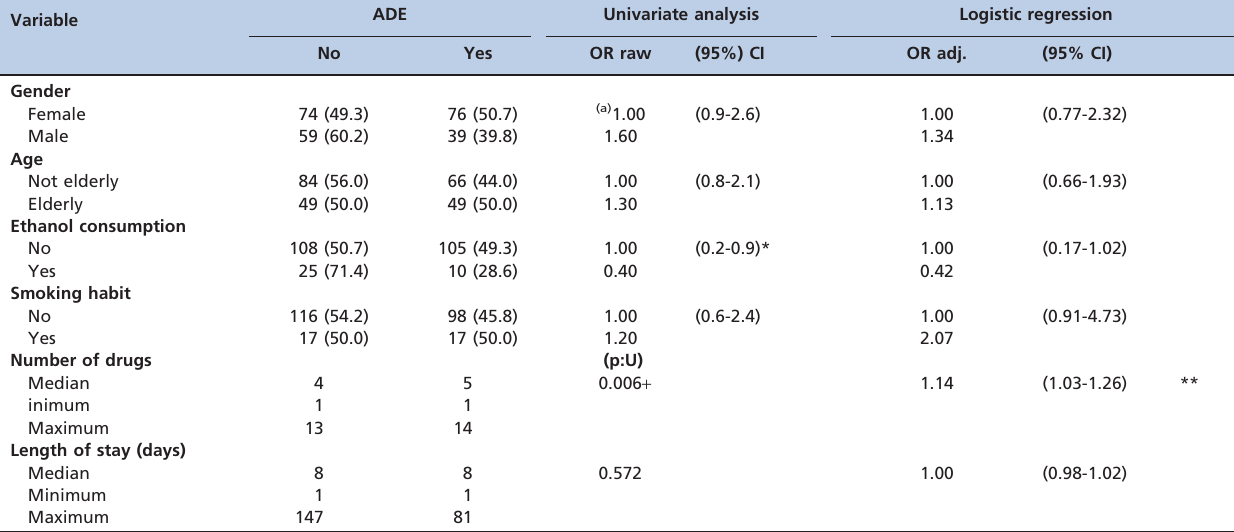
Table 1 - Frequency of ADEs identified according to potential risk factors in groups of patients admitted to the internal medicine ward (n =